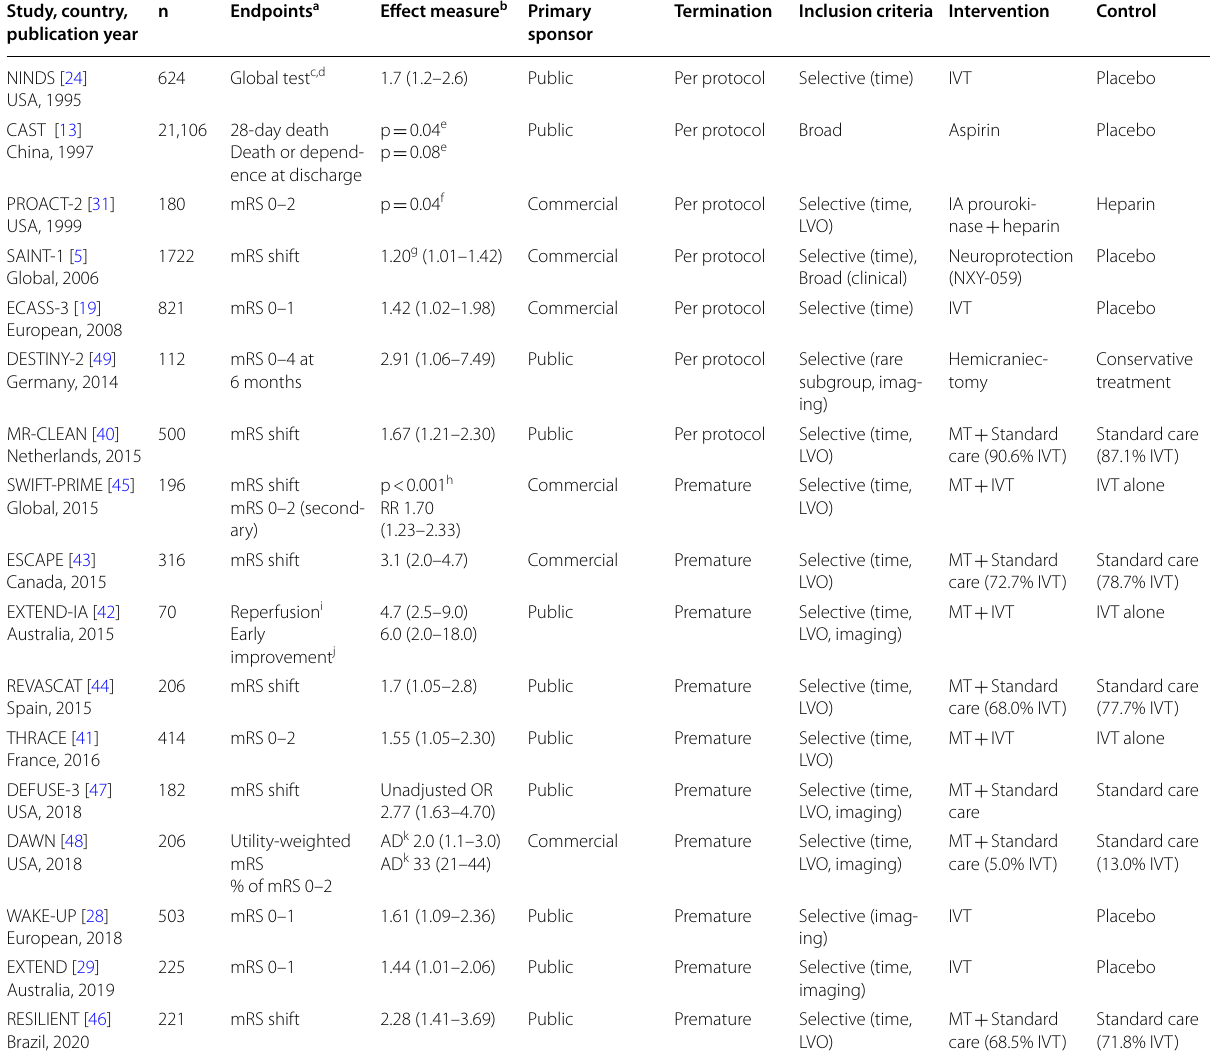
Table 1 Positive trials